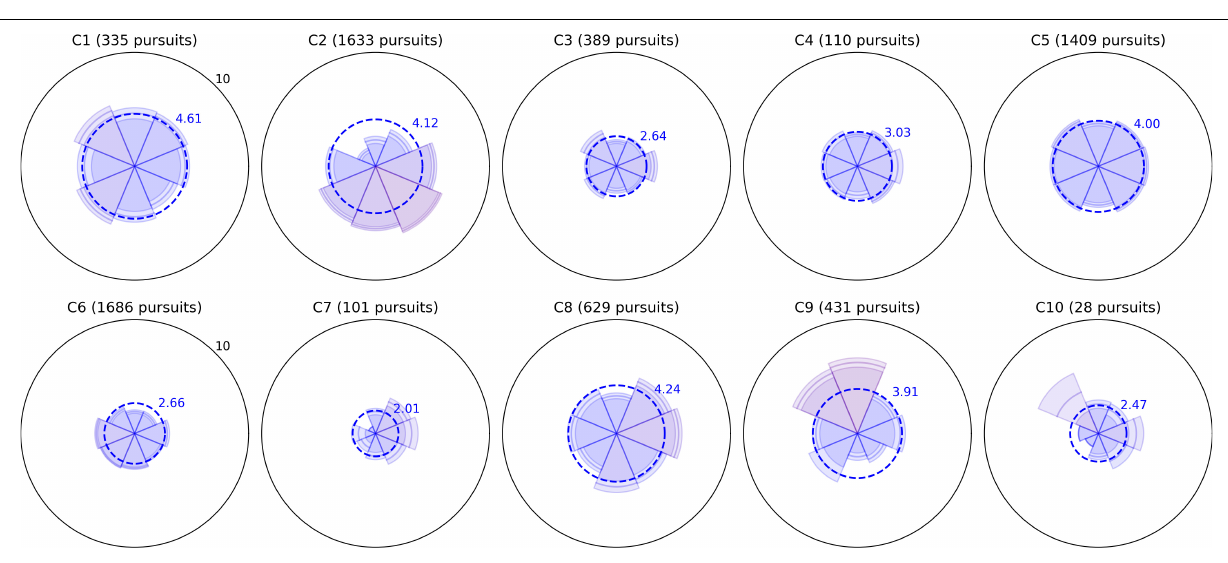
FIGURE 5 | Radial plots of mean pursuit distance computed as path length between the first and last gaze points in the pursuit. As in previous figures, pursuits in the Moving Bubbles task were binned into eight directions and the radius of each sector represents the mean distance of all pursuits falling in that directional bin. The upper radial axis limit of each plot is 10 ◦ of visual arc. Overall mean distance is denoted by the dotted blue ring and the color of each sector changes gradually from blue to red as the mean distance for that direction exceeds the overall mean. The lighter ring segments at the end of each sector represent the standard error of mean distance in that